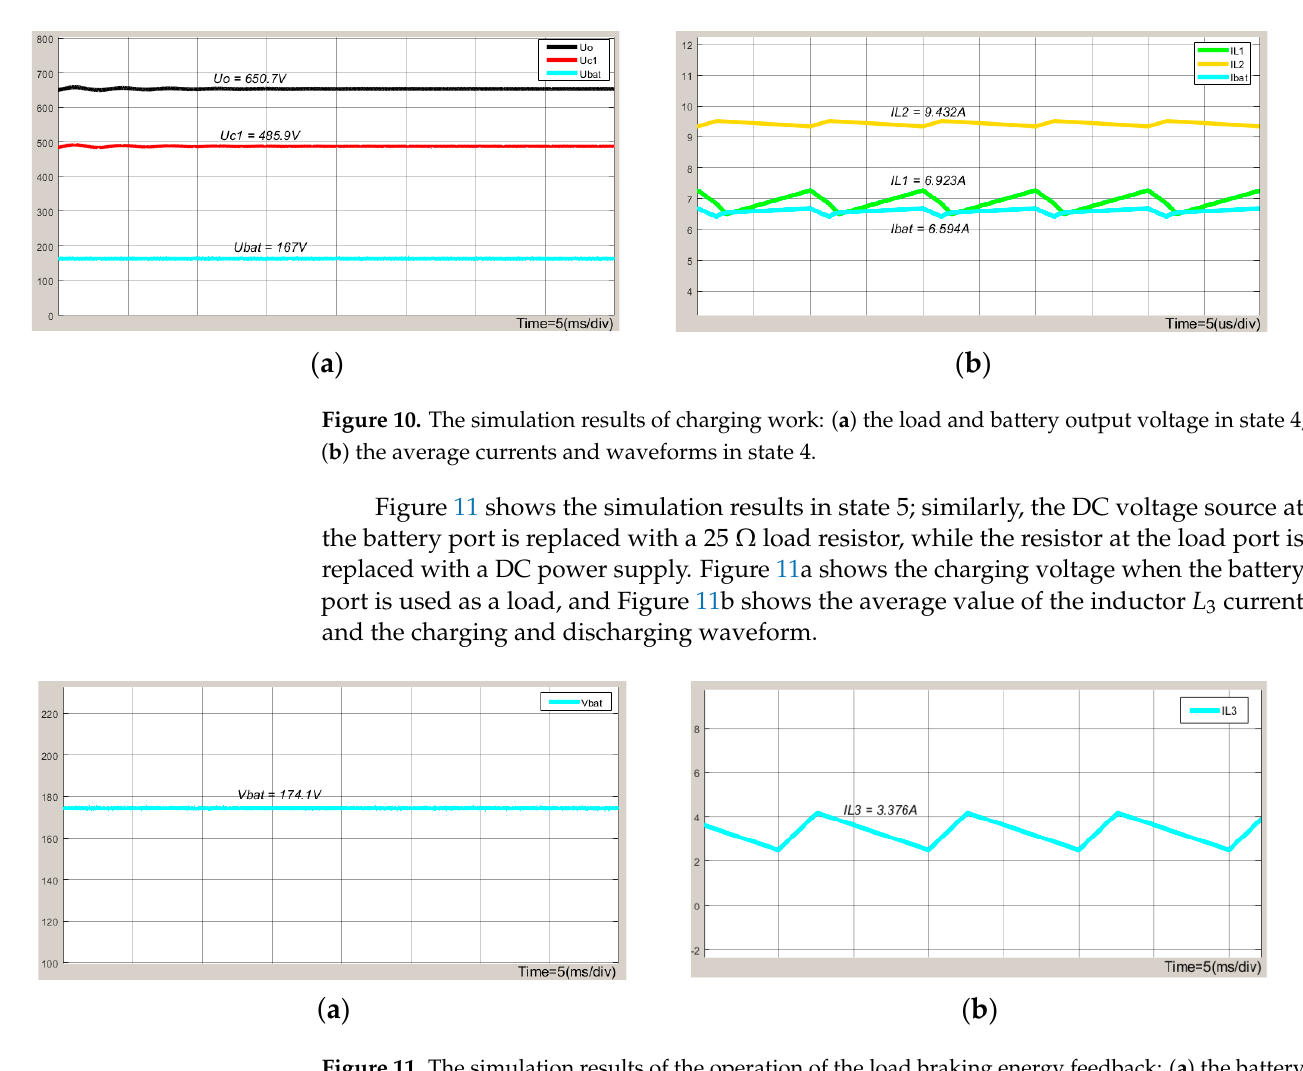
tery charging voltage in state 5; ( b ) the inductance current in state 5. charging voltage in state 5; ( b ) the inductance current in state